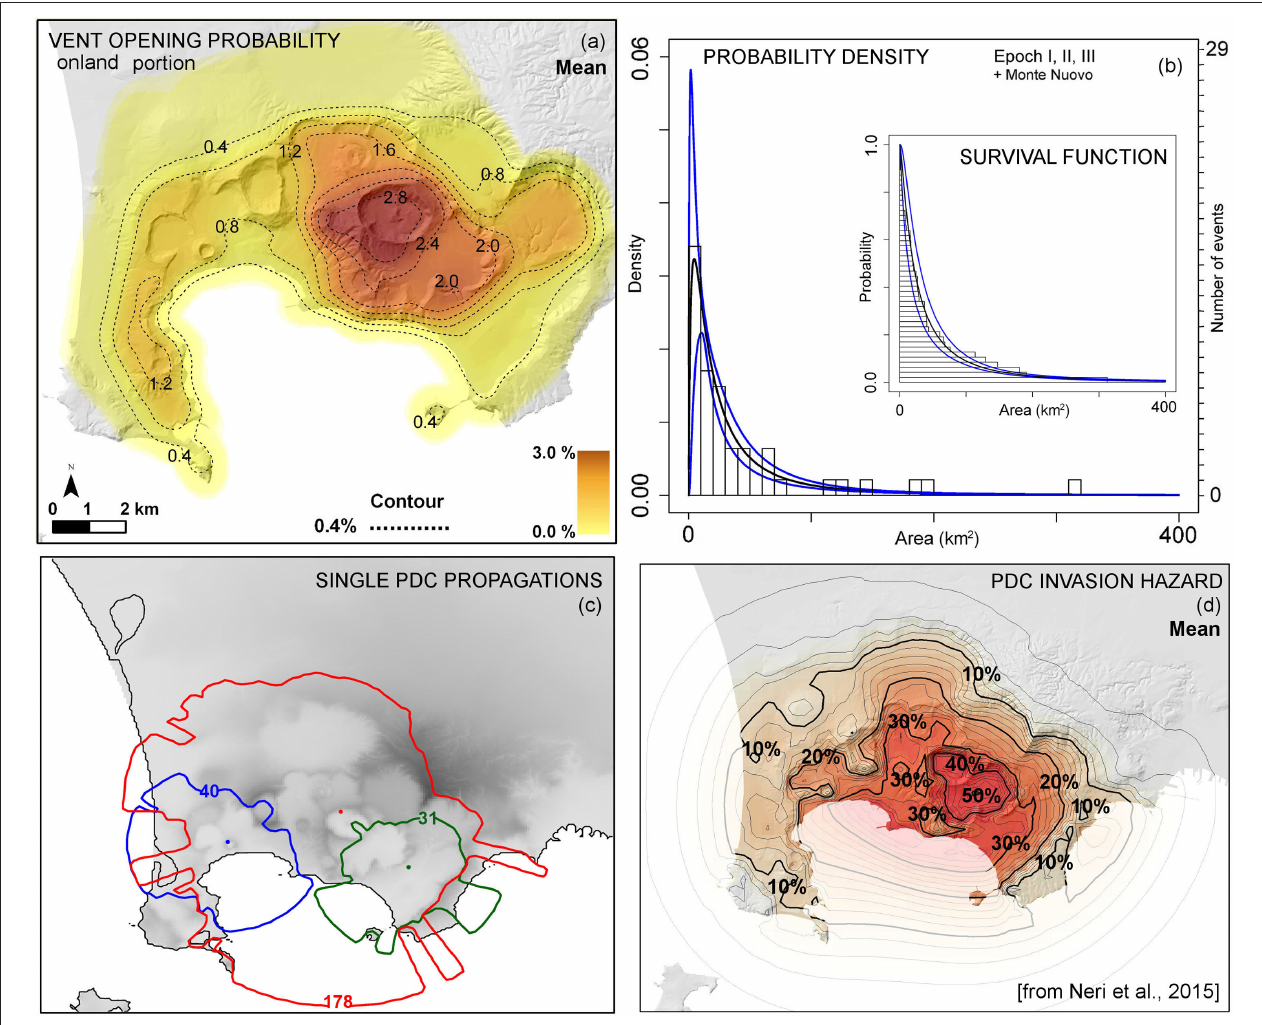
FIGURE 2 | (a) Probability map of new vent opening location, modified from Bevilacqua et al. (2015). Contours and colors indicate the mean percentage probability of vent opening per km 2 conditional on the occurrence of an eruption originating on-land. (b) Histograms of the PDC invasion areas as estimated for the events in the last 15 kyr, modified from Neri et al. (2015). Probability density functions (log-normal class) are displayed for the invasion areas—the black curve is the mean value and the blue curves are the 5th and 95th uncertainty bounds. In the small box are included the mean survival functions with their uncertainty bounds. (c) Example of the invasion areas of three PDC simulation runs with different origin and areal extent. Different colors correspond to different runs. The colored contours envelop the invaded areas and the numbers on the contours are the values of the area invaded. (d) PDC invasion probability map as computed in Neri et al. (2015) from the invasion areas distribution and the vent opening map displayed. Contours and colors indicate the mean percentage probability of PDC invasion conditional on the occurrence of an explosive eruption originating